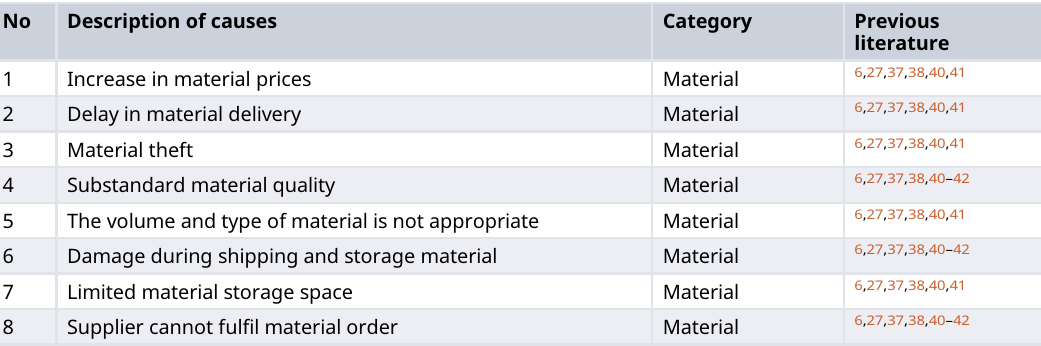
Table 1. Factors causing project delays based on previous